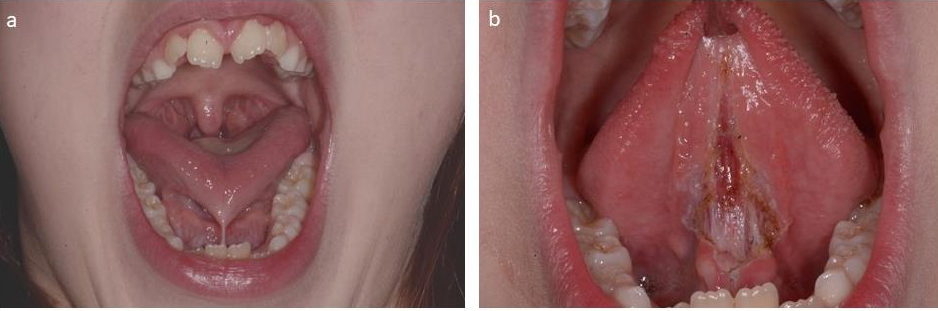
Figure 3. Quantitative evaluation t4: ( a ) (MAB), ( b ) (MIO), ( c ) (MOTTIP), ( d ) (PROTRUSIONE). 4. Discussion Through the use of this protocol, the efficacy of the diode laser technique was demonstrated for lingual frenulectomies in pediatric patients; this technique makes it possible to quantitatively increase the aforementioned parameters until physiological values are reached, bringing about the acquisition of full lingual functionality with minor anxiety and pain. Several studies have performed millimetrical evaluations to determine the best methods for the correct diagnosis of ankyloglossia [23–25], but none of them has considered the different pre- and post- operative increases, nor have they examined the use of different type of lasers. Marchesan et al. presented a quantitative method to classify the pathological lingual frenulum with no consideration of improvement after surgical intervention [31]. Yoon et al. [25] employed the same millimetrical device used in our study (QTT)® , but the aim of their study was to validate millimetrical parameters as an initial screening tool to asses for restrictions in tongue mobility. However, in our study, millimetrical evaluation was essential not only for the screening, but also to verify the efficacy of diode laser technology in the improvement of tongue mobility after surgical intervention. In this way, an unexpected result of this study was the observed continuous improvement in the first month after surgery; our analysis demonstrates how the increase from T0 to T1, T2, T3 and T4 is gradual in relation to the better functionality of the tongue. A similar correlation was noted in a study by Ghaheri BA et al. [32], in which enhancement after frenulectomy occurred early (1 week postoperatively), and continued to improve one month thereafter; both infants with classic anterior